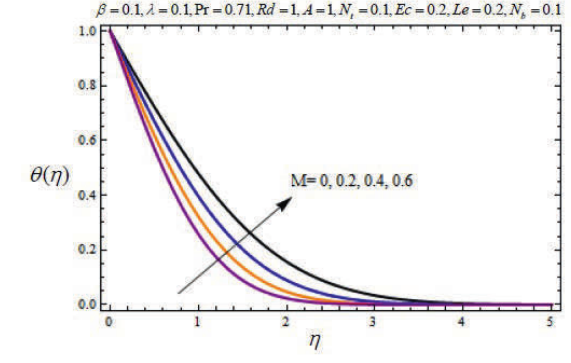
Fig. 13: Variation of temperature profile θ ( η ) with η for several val- ues of magnetic parameter M